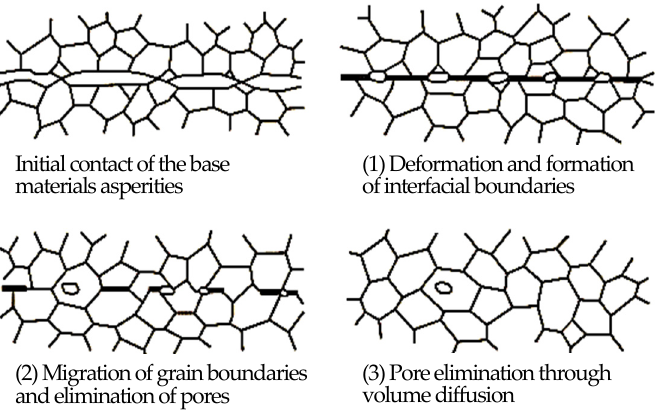
Figure 1. Overview of the different stages during diffusion bonding.